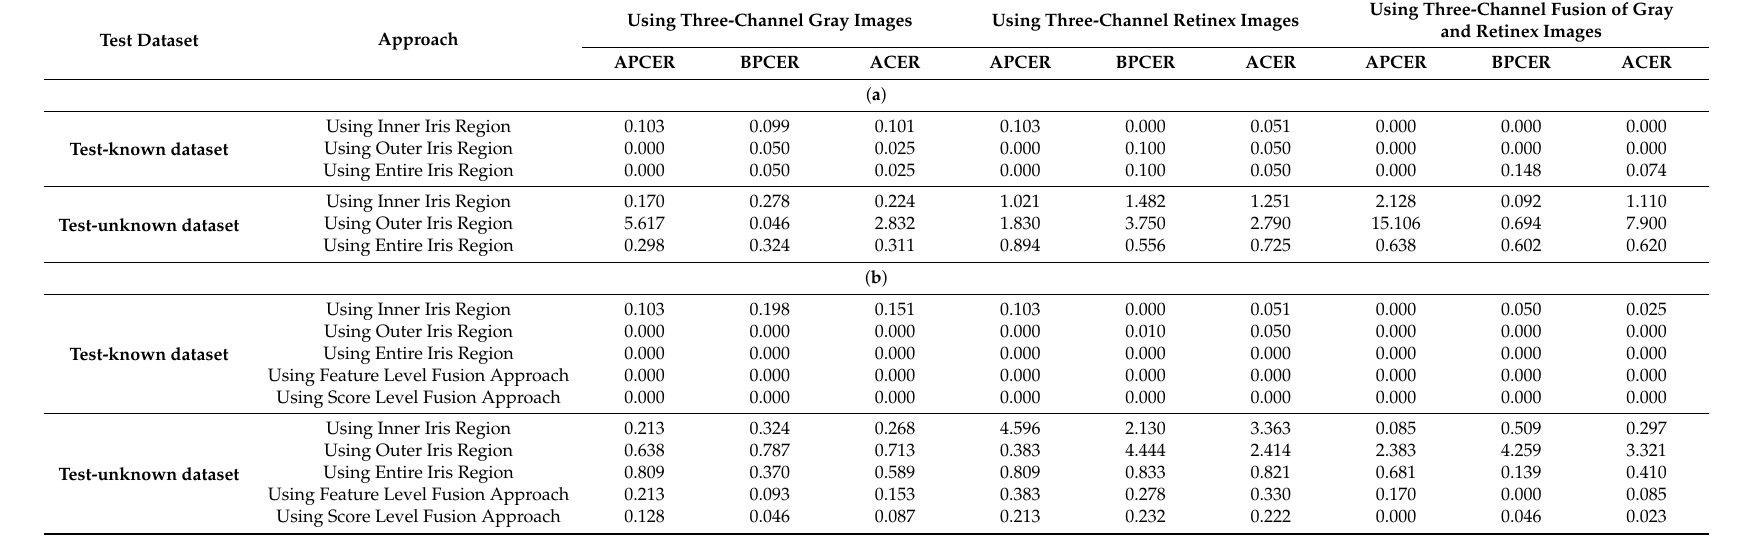
Table 5. (a) Detection errors (attack presentation classification error rate (APCER), bona fide presentation classification error rate (BPCER), and average classification error rate (ACER)) of iPAD based on CNN method for classification using Warsaw-2017 dataset and three different kinds of input image (unit: %); (b) Detection errors (APCER, BPCER, and ACER) of iPAD based on SVM method for classification using Warsaw-2017 dataset and three different kinds of input image (unit: